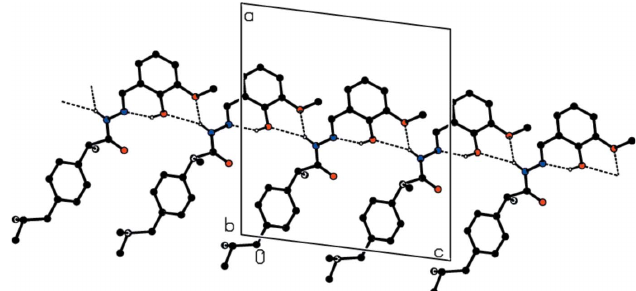
Figure 2 A portion of one chain viewed along the b -axis with the O—H (cid:3)(cid:3)(cid:3) N and